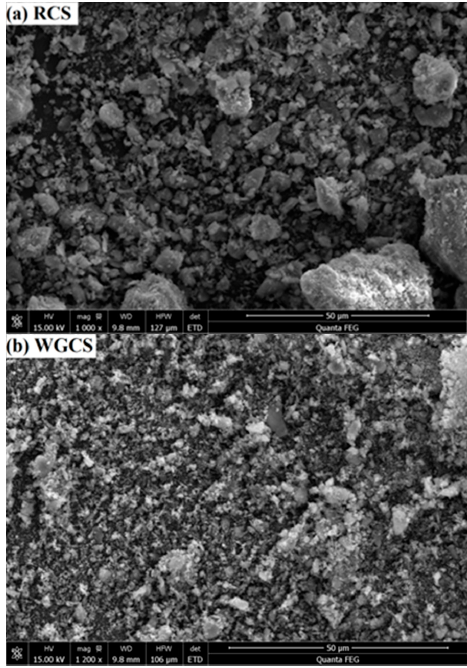
Figure 2. SEM images of RCS and WGCS. ( a ) RCS; ( b ) WGCS.